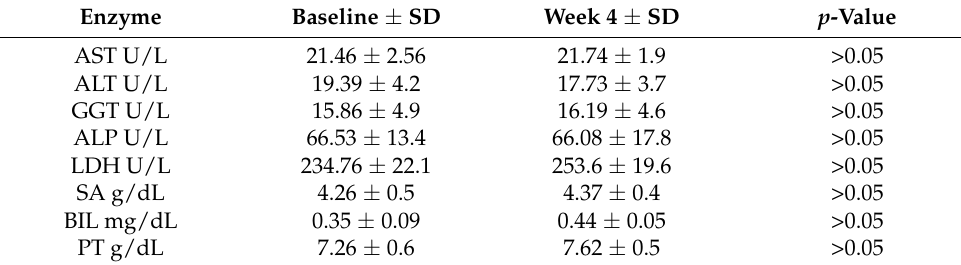
Table 3. Liver function tests, baseline vs. week 4 of follow-up levels.